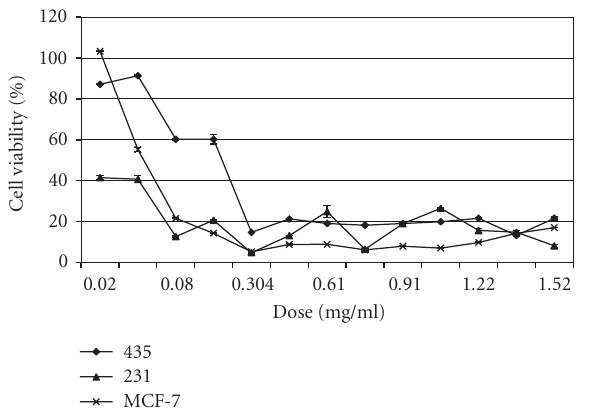
Figure 3: Toxicity of Onxol (cid:2) to human breast cancer cell lines 435, 231, and MCF-7.